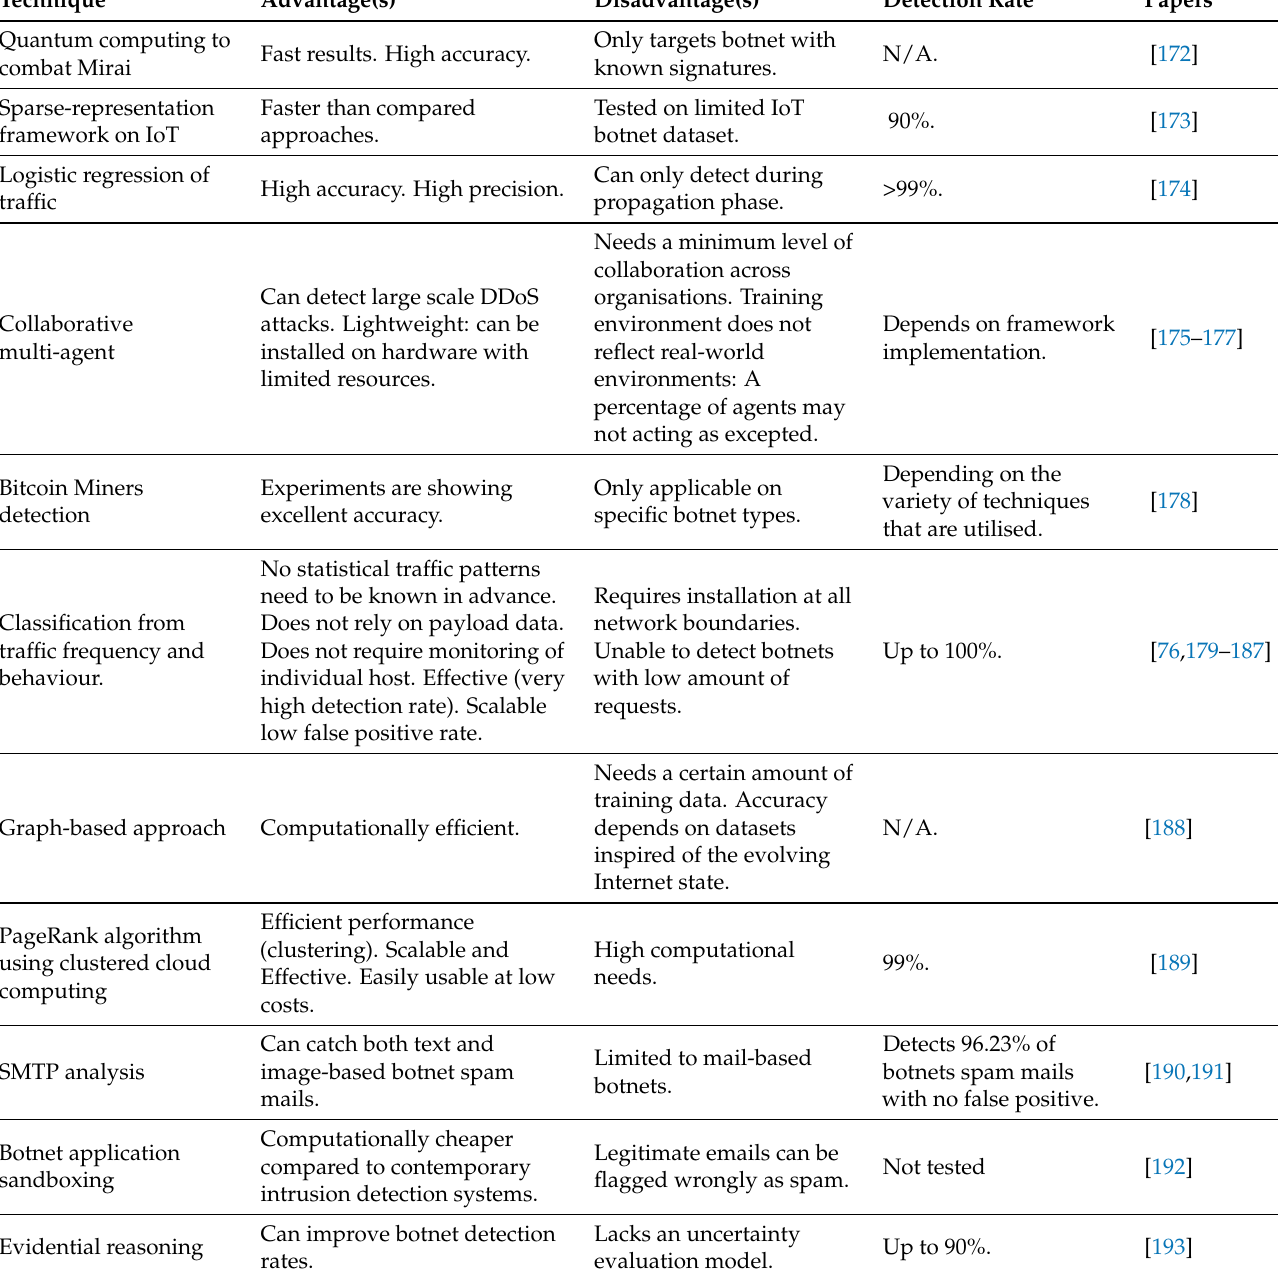
Table 7. Papers describing detection of botnets in IoT and P2P-based environments. Each column describes the overall technique, known advantages, disadvantages, detection rate and related papers,